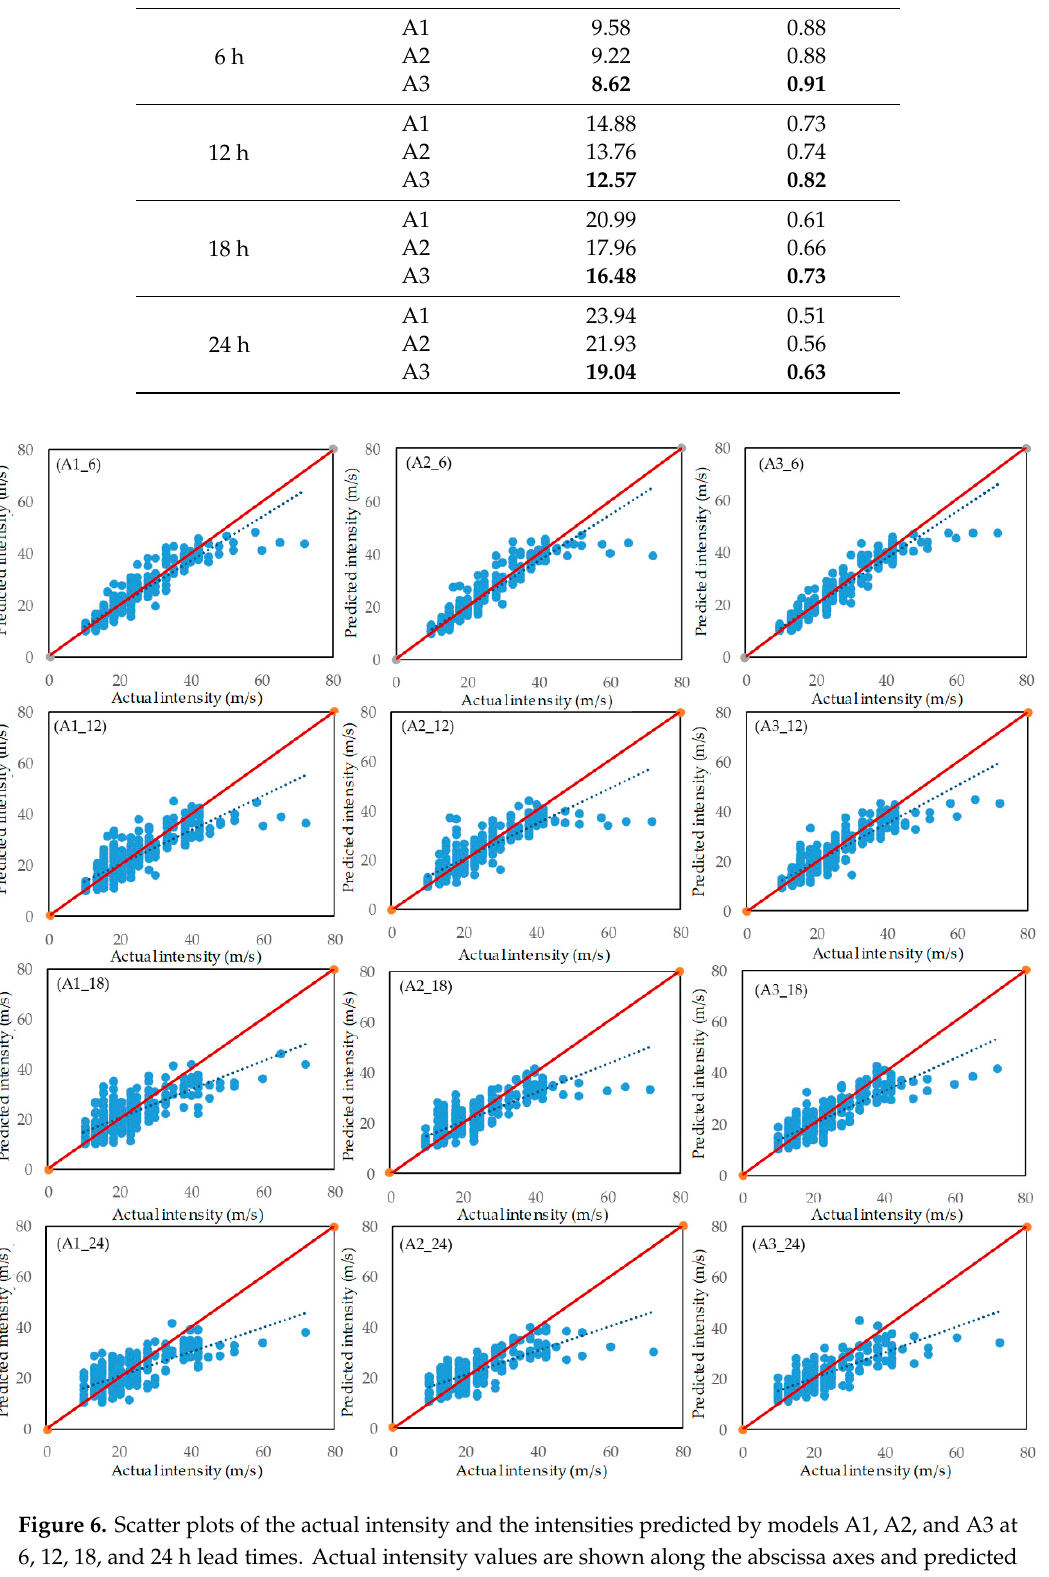
Table 8. Comparative analysis of TC intensity prediction at 6, 12, 18, and 24 h lead times. Lead Time Model